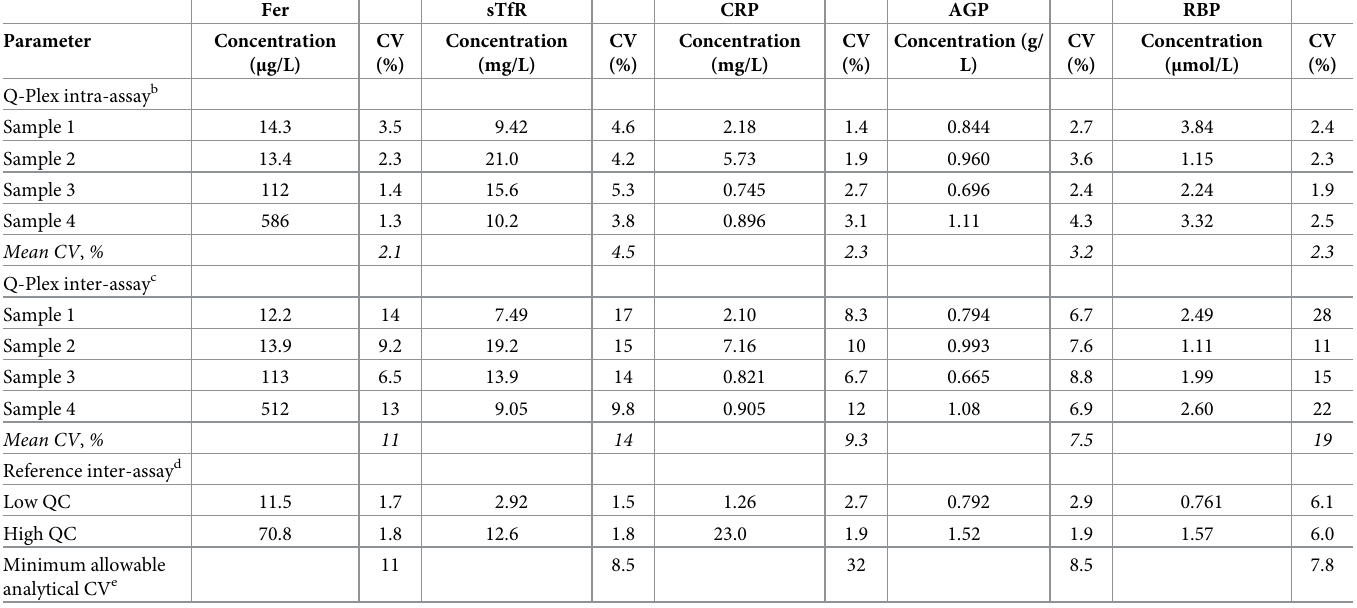
Table 5. Q-Plex and reference assay imprecision for serum samples a .